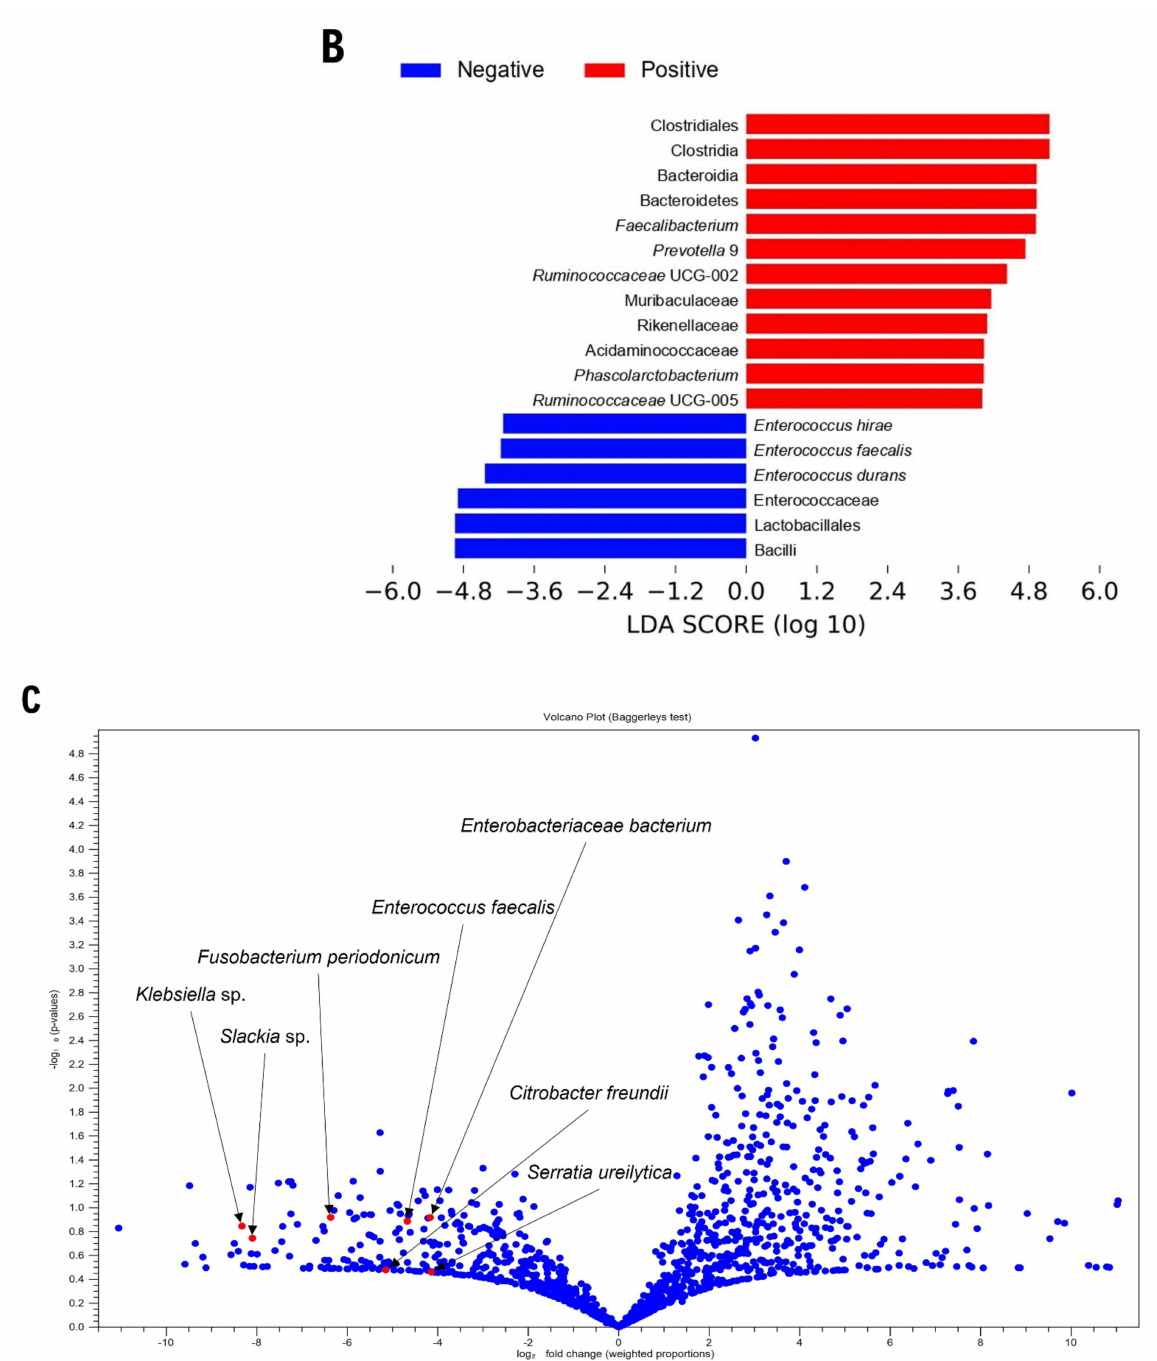
Figure 3. Bacterial taxa associated with the presence or absence of Blastocystis according to lin- ear discriminant analysis (LDA) effect size (LEfSe). ( A ) LEfSe taxonomic cladogram showing dif- ferences in fecal taxa. Dot size is proportional to taxon abundance. Letters correspond to the following taxa: (a) Muribaculaceae, (b) Prevotella 9 , (c) Rikenellaceae, (d) Enterococcaceae, (e) Faecal- ibacterium , (f) Ruminococcaceae UCG-002, (g) Ruminococcaceae UCG-005, (h) Phascolarctobacterium , and (i) Acidaminococcaceae. ( B ) LDA scores of differentially abundant taxa in the fecal microbiome of the Blastocystis -negative (blue) and Blastocystis -positive (red) groups. Length denotes effect size. p = 0.05, Kruskal–Wallis test; LDA score > 4.0. ( C ) Volcano plot showing bacterial taxa related to Blastocystis